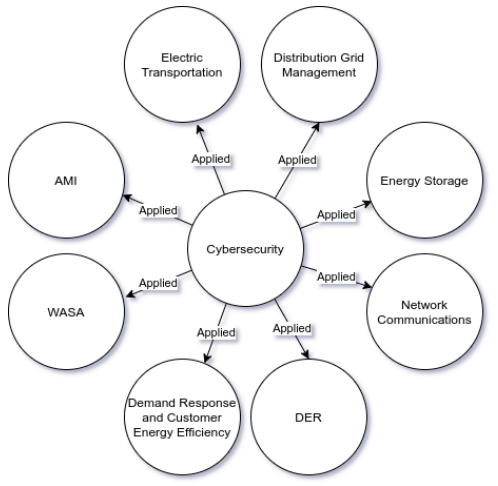
Figure 1. NIST priority areas: Importance of cybersecurity in priority